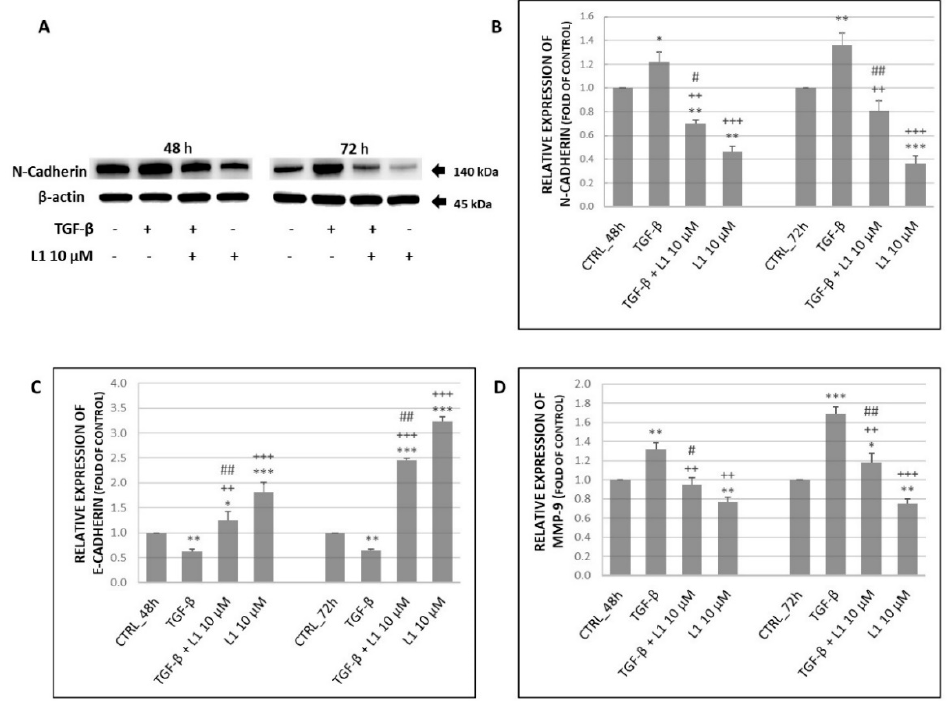
Figure 7. Changes in expression of N-Cadherin ( A ) along with its densitometry analyses ( B ) of western blot results. Relative expression of E-cadherin ( C ) and MMP-9 ( D ) obtained by flow cytometry analyses. All after 48 h and 72 h of L1 treatment. Representative data of three independent experiments are presented. Significantly different * p < 0.05, ** p < 0.01, *** p < 0.001 vs. untreated cells (control); ++ p < 0.01, +++ p < 0.001 vs. TGF- β ; # p < 0.05, ## p < 0.01 vs. L1.